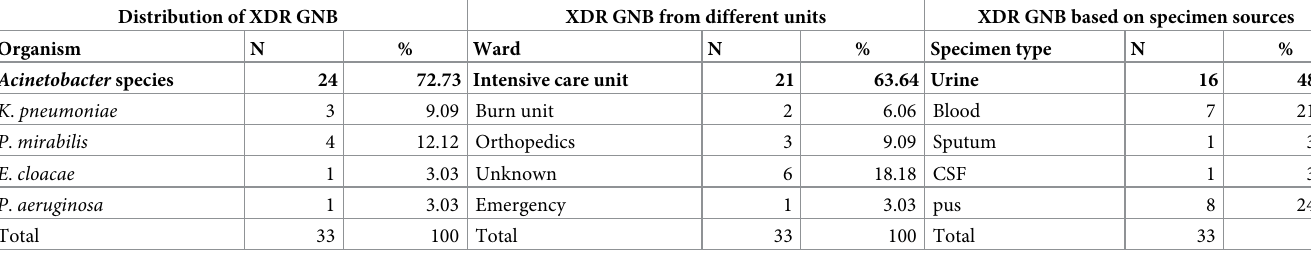
Table 1. Distribution of extremely drug-resistant gram-negative